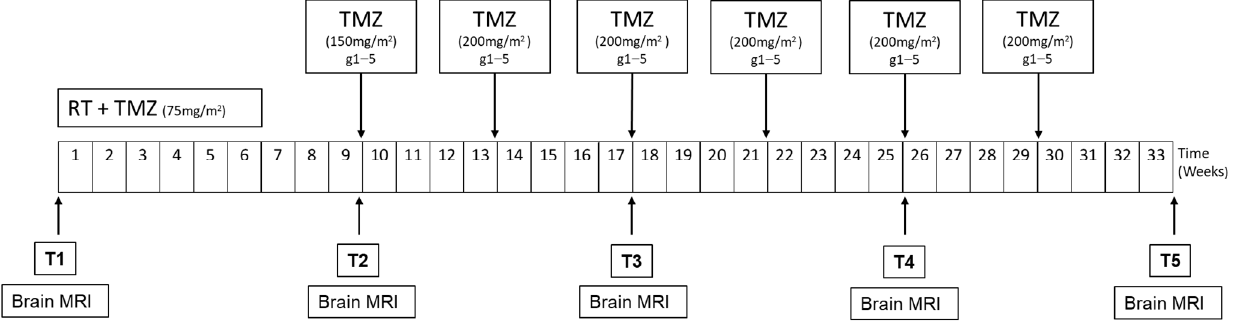
Figure 1. Study design. RT , radiotherapy cycle; TMZ , temozolomide; MRI , magnetic resonance. Blood sampling was done at time points T1, T2, T3, T4 and T5. Duration of the study is expressed in weeks.